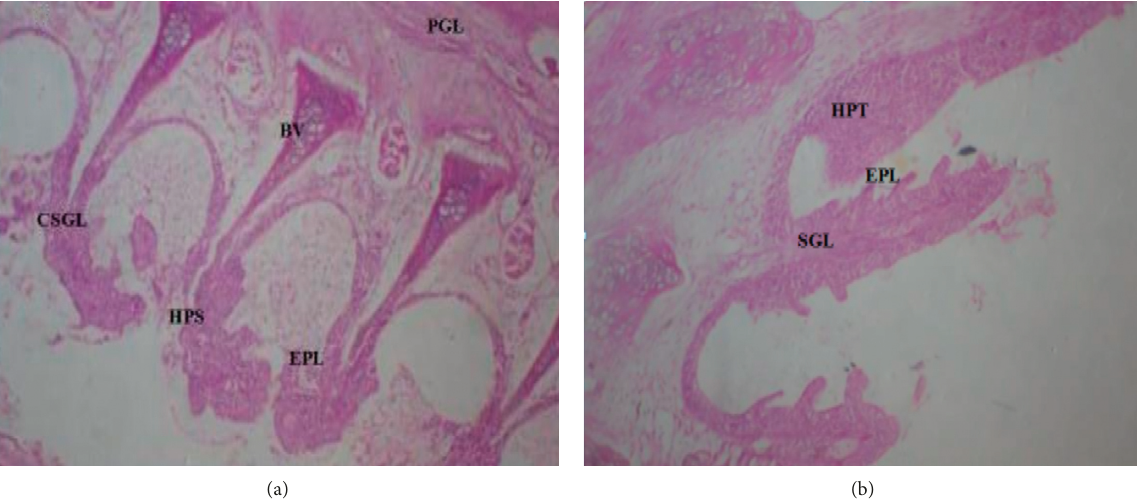
Figure 4: (a) Histological section of gill exposed to nano-Al 2 O 3 showing primary gill lamella (PGL), curved secondary gill lamella (CSGL), epithelial hyperplasia (HPS), epithelial lifting (EPL), and blood vessel (BV) (H&E stains, × 400). (b) Histological section of gill exposed to bulk SiO/CuO (1 :1) showing secondary gill lamella (SGL), hypertrophy (HPT), and epithelial lifting (EPL) (H&E stains, ×